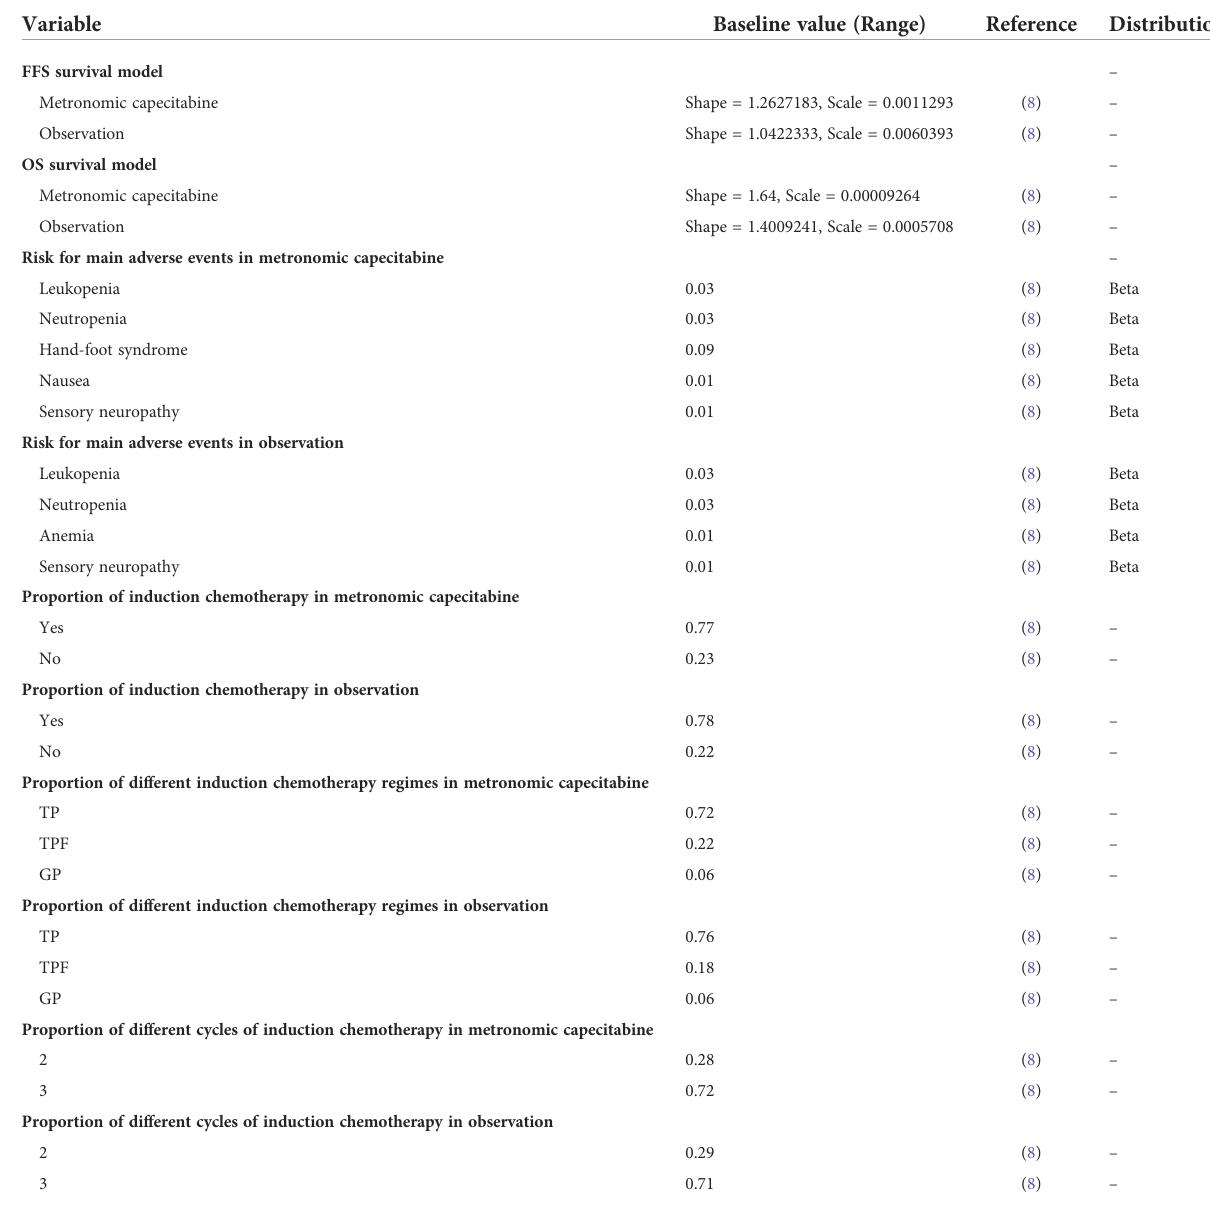
TABLE 1 Key clinical data in trial of NCT02958111.